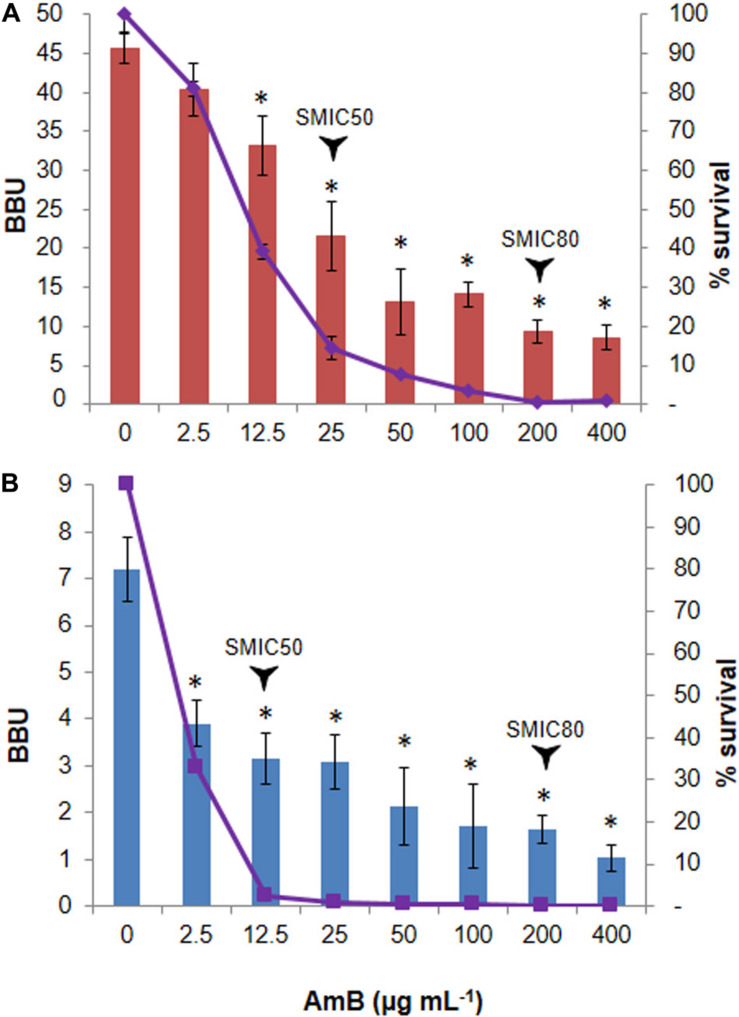
Biphasic killing pattern in response to Amphotericin B (AmB) treatment on Candida tropicalis biofilms. The 48 h-old biofilms of the (A) reference NCPF 3111-N° 1-, and (B) clinical-N° 2- C. tropicalis strains were treated with 2.5–400 μg mL–1 AmB. The biofilm biomass units (BBU-bar) quantified by crystal violet (CV) staining, and the fraction of surviving cells (% survival- line) calculated by viable colony-forming units, were plotted as a function of AmB concentration. Error bars represent the standard deviations of the means of three independent experiments performed in triplicate. *p < 0.01 was considered significant for comparisons with untreated biofilms.